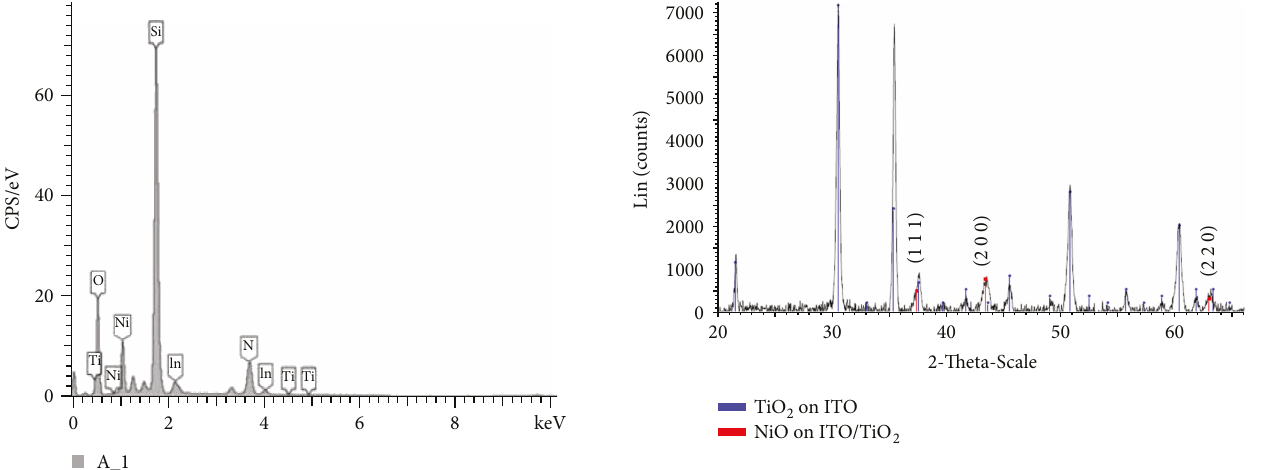
/NiO heterojunction 2